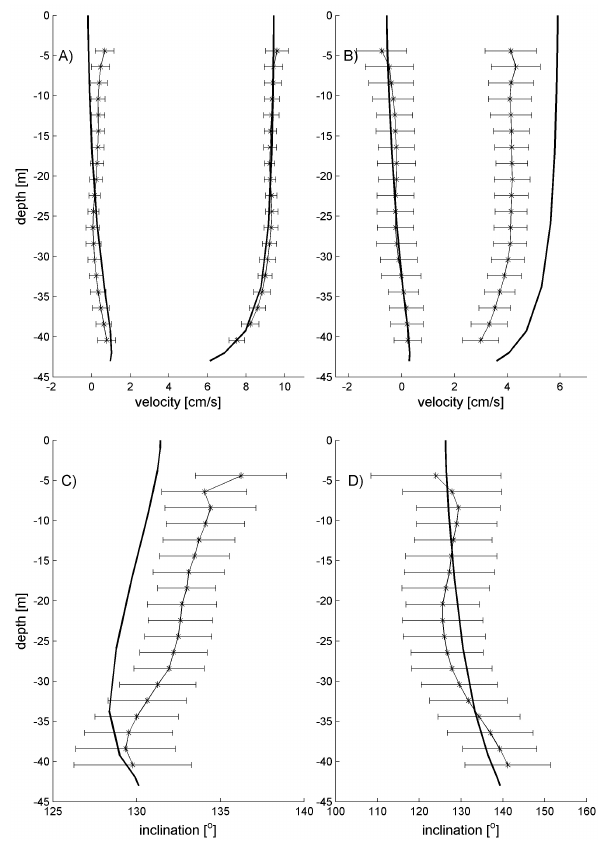
Fig. 13. Tidal ellipse’s vertical structures at the J station for M2: (A) – major and minor semi-axis, (C) – inclination angle, and K1: (B) – major and minor semi-axis, (D) – inclination angle tidal con- stituents. Stars represent observed values, error bars mark the ob- servation error, and the bold line represents model